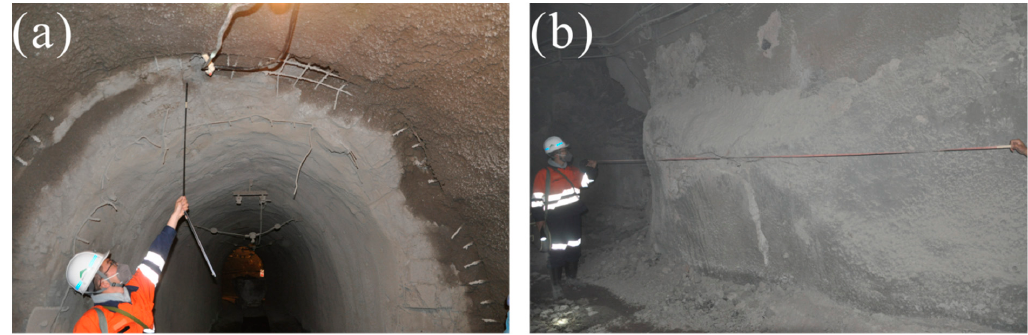
Figure 1. Field investigation. ( a ) Axial deformation measurement; ( b ) Radial deformation measurement.